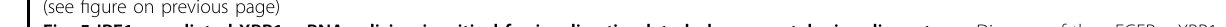
Fig. 5 IRE1 α -mediated XBP1 mRNA splicing is critical for insulin-stimulated glucose uptake in adipocytes. a Diagram of the pEGFP-mXBP1 reporter construct (see Materials and methods). b – d 3T3-L1 adipocytes were transfected with pEGFP-mXBP1 and treated for 6 h with insulin (1 μ g ml − 1 ) or thapsigargin (200 nM). The levels of GFP protein ( b ) and XBP1s mRNA ( c ) were examined using fl uorescence microscopy and real-time PCR, respectively. GFP expression area and intensity were quanti fi ed with ImageJ ( d ). e Diagram of wild-type (pcDNA-WT-mXBP1u, upper) or mutant (pcDNA-Mut-mXBP1u, lower) constructs used for functional analyses of IRE1 α -induced XBP1 splicing (see Materials and methods). f – i Adipocytes were transfected with pcDNA-WT-mXBP1u construct, pretreated for 1 h with vehicle or IRE1 α inhibitor STF-083010 (STF, 50 uM), then treated with insulin (1 μ g ml − 1 , 6 h) as indicated. f Effect of insulin on XBP1s mRNA and protein levels in adipocytes transfected with pcDNA-WT-mXBP1u. g – i Effect of STF-08310 on XBP1s and FGF21 mRNA levels, DR1 activity, and glucose uptake rate. j – l Effect of mutant construct (pcDNA-Mut-mXBP1u) on XBP1s and FGF21 mRNA levels, DR1 activity and glucose uptake rate. Values are presented as the means ± SEM of three independent experiments. * P < 0.05 compared to the insulin-untreated group. # P < 0.05 compared to the insulin-treated group. @ P < 0.05 compared to the EV-transfected group. & P < 0.05 compared to the pcDNA-WT-mXBP1u-transfected